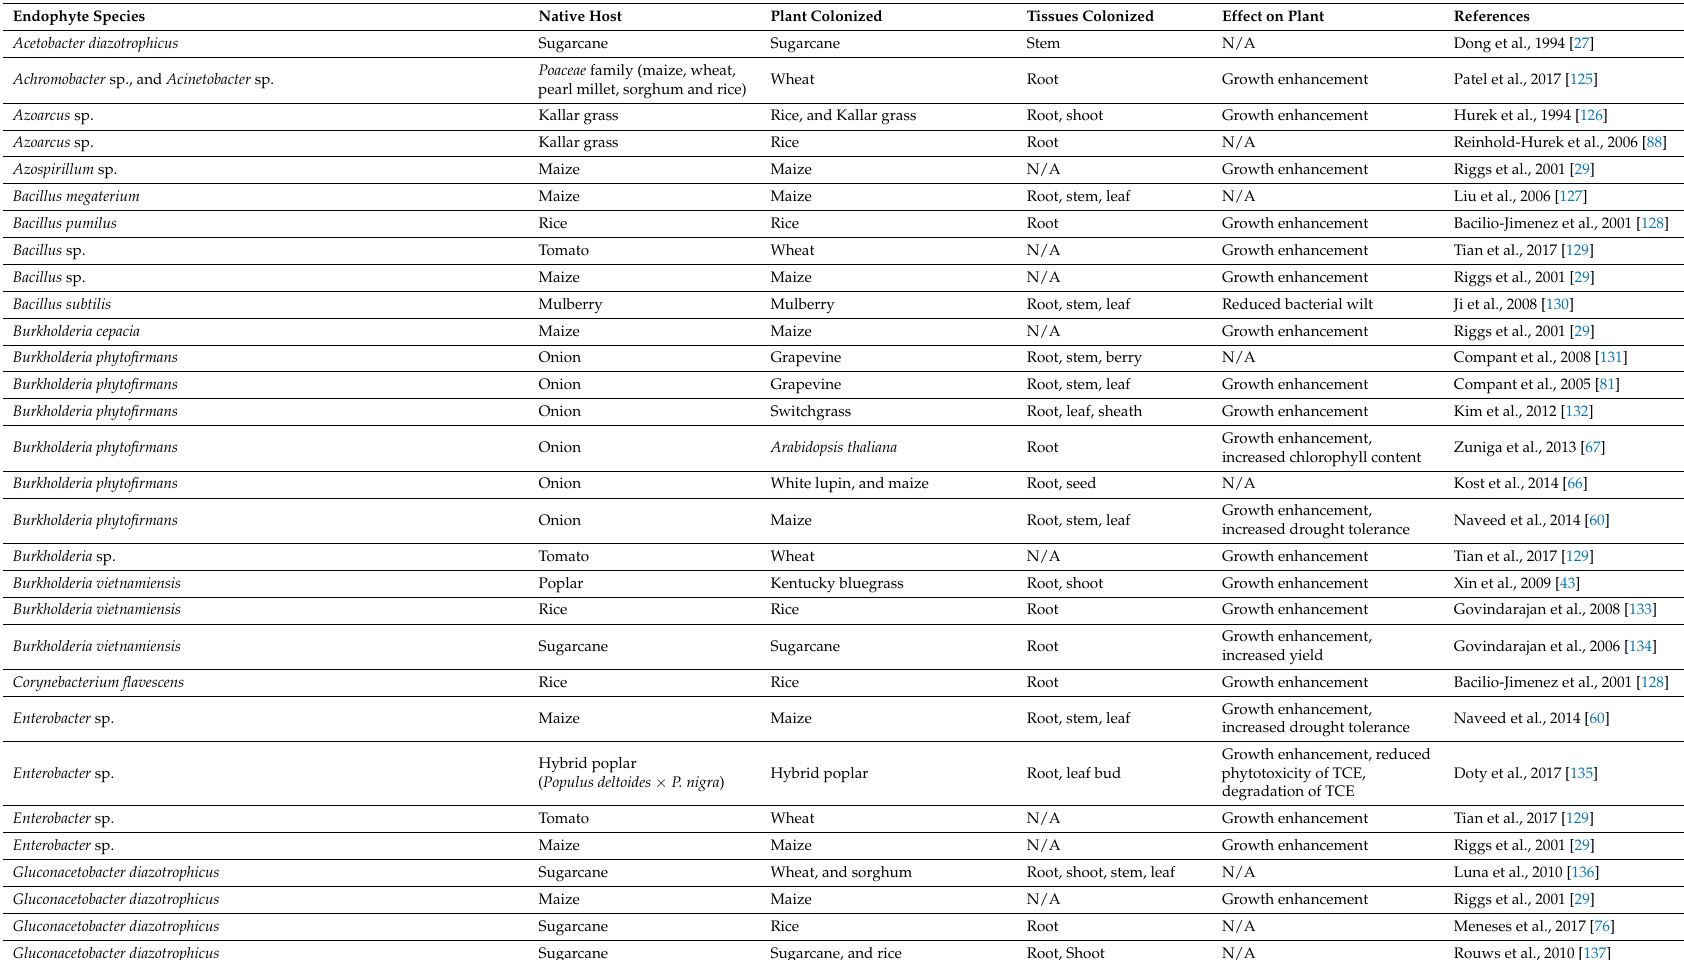
Table 1. Colonization of different plants by bacterial